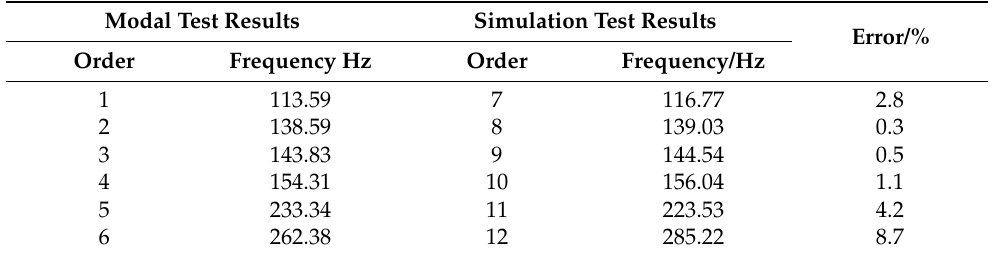
Table 2. Free modal test results and simulation results of the rotor of the rubbing